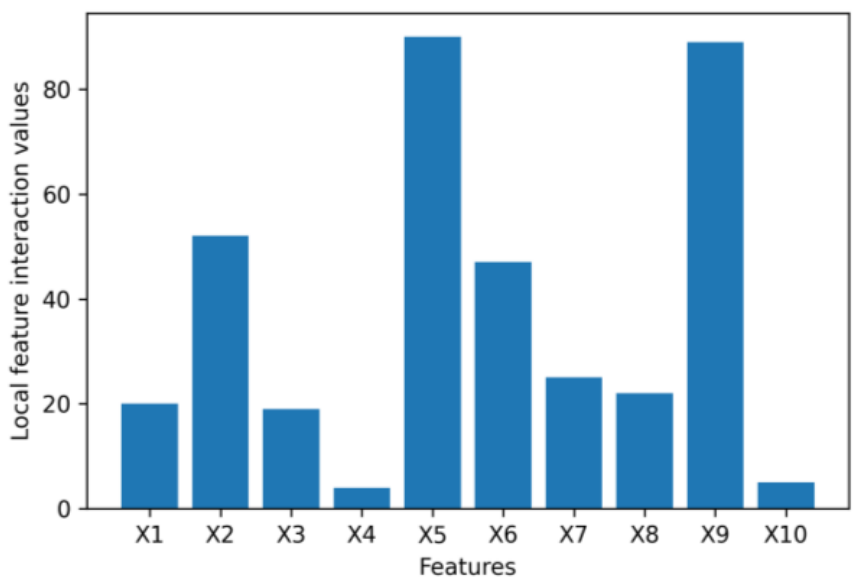
Figure 15. Local feature interaction values for dataset 1.